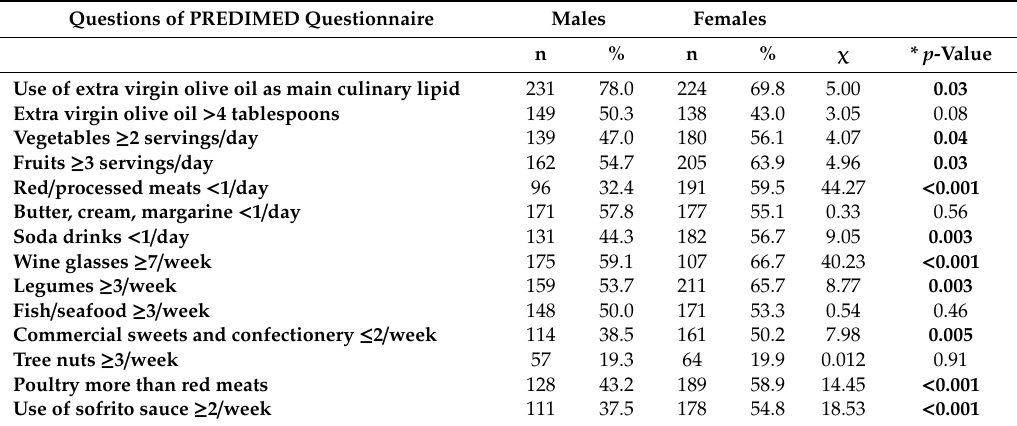
Table 3. Response frequencies of dietary components included in the PREvenci ó n con DIetaMEDiterr á nea (PREDIMED) questionnaire in the study population according to